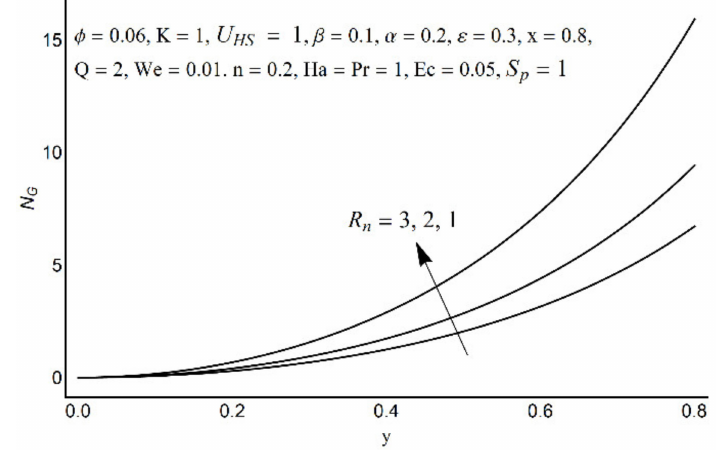
Figure 15. Entropy generation number for different values of R n